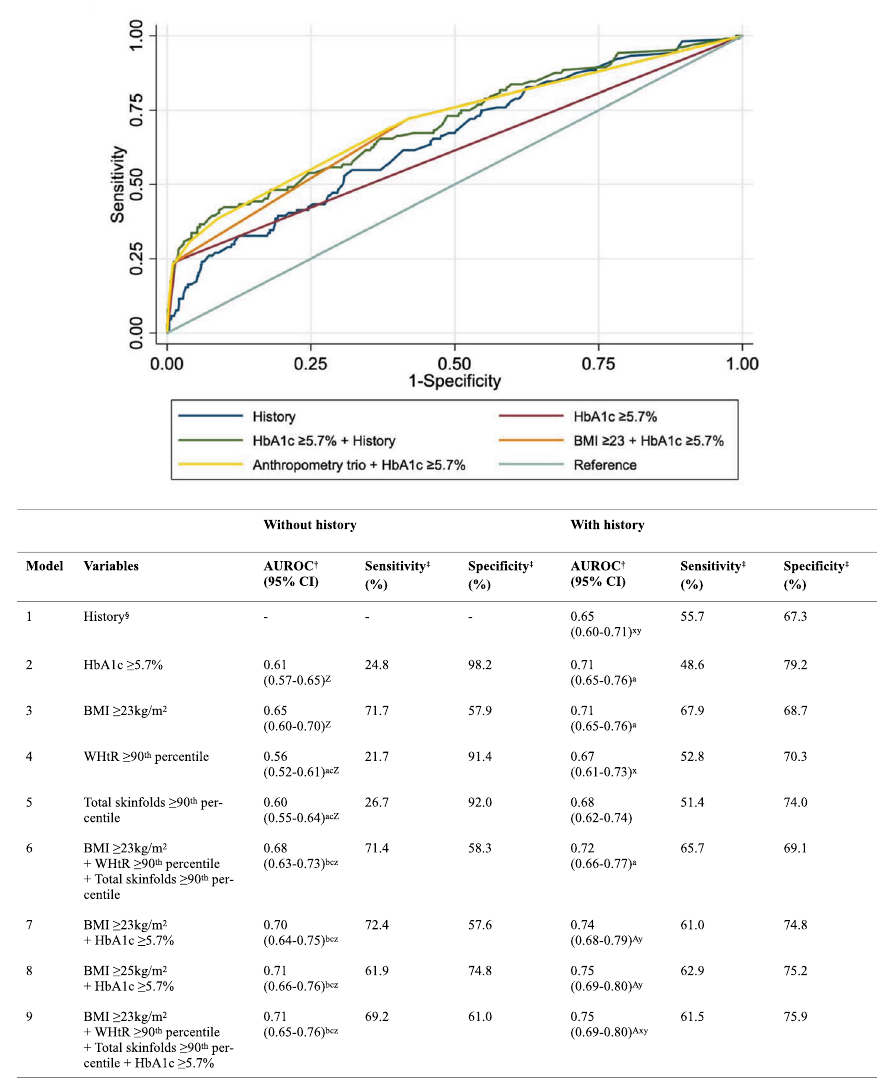
Figure 2. Categorical measures of anthropometry and HbA1c – The AUROC, sensitivity and specificity in detecting dysglycemia without and with adjustment for